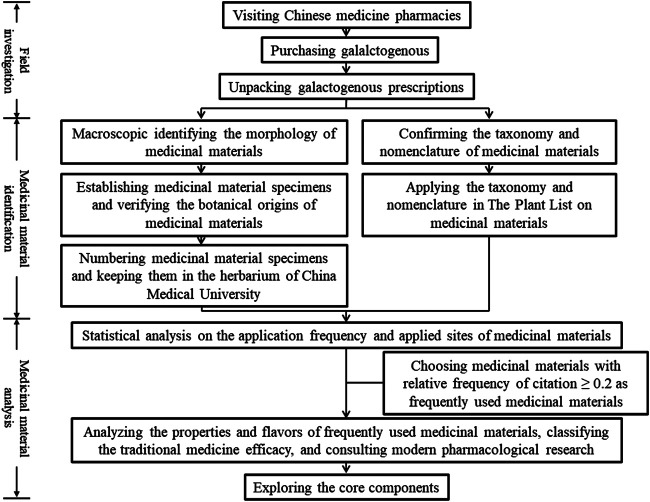
Research flowchart.